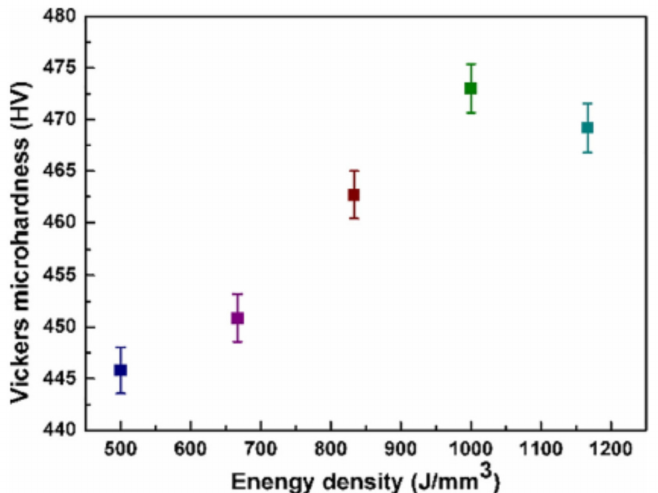
Figure 2. The relationship between energy density and microhardness of pure tungsten (W) manu- factured by the selective laser melting (SLM)